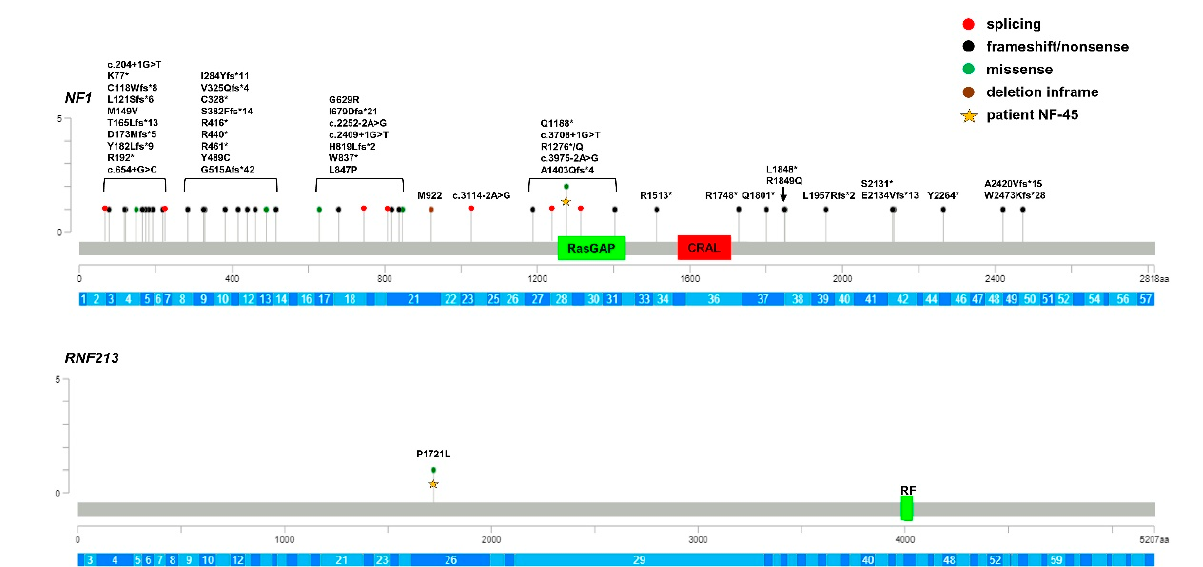
Figure 2. Lolliplot graph showing distribution and frequency of NF1 and RNF213 variants identified in NF1 patients. Yellow star identifies variants carried by the same patient. RasGAP: Ras GTPase activating protein domain; CRAL: CRAL-TRIO lipid-binding domain (cellular retinaldehyde-binding protein and TRIO guanine exchange factor); RF: RING finger domain; aa: number of protein amino acids; c.: number of nucleotide in the coding region of the gene. *: stop codon. The gene exons are schematized in dark and light blue. All the identi fi ed NF1 variants are absent in public databases and are either absent or present at very low frequencies (MAF < 1:10.000) in our exome control database; among them, 41 were reported in Clinvar. Thus, the clinical suspicion of NF1 was con fi rmed by genetic testing, both in isolated and syndromic patients.